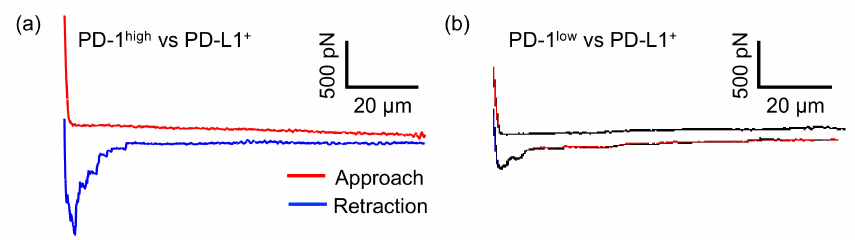
Figure 3. Typical force curves obtained between PD-L1 + cancer cells and either PD-1 high ( a ) or PD-1 low ( b ) cell pairs. Dwell time, 20 s.